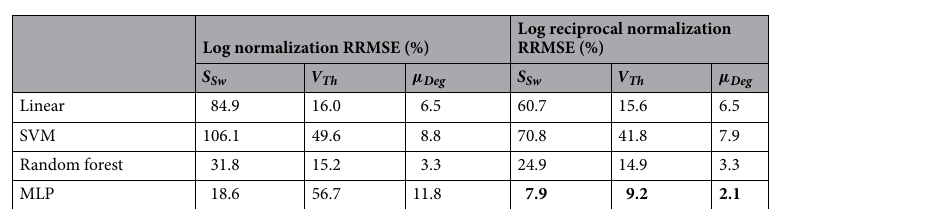
Figure 1. Box plots of normalized I D data distributions of 500 validation samples in various voltages were compared using normalization methods. ( a ) data distribution of log-normalized samples; ( b ) data distribution of log-reciprocal normalized samples.